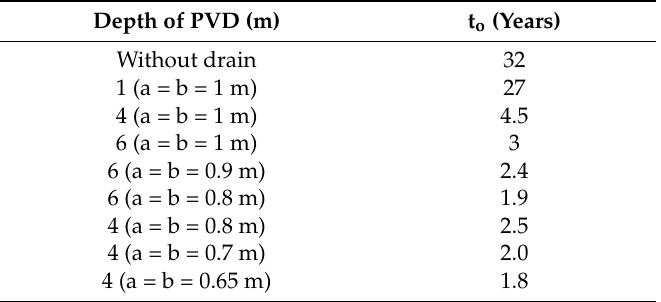
Table 4. Values of t o as a function of PVD penetration and surface layout (c = 0.05 m).